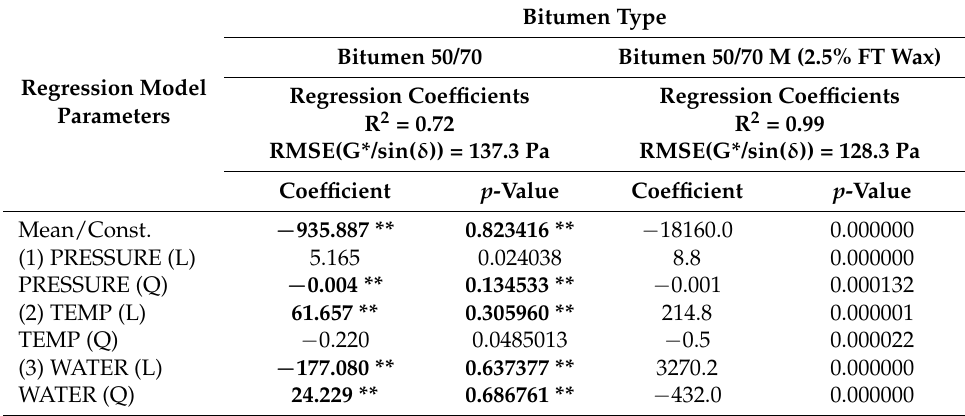
Table 6. Fitting parameters of the objective function of G*/sin( δ ) for bitumen 50/70 and 50/70 M (2.5% FT wax).